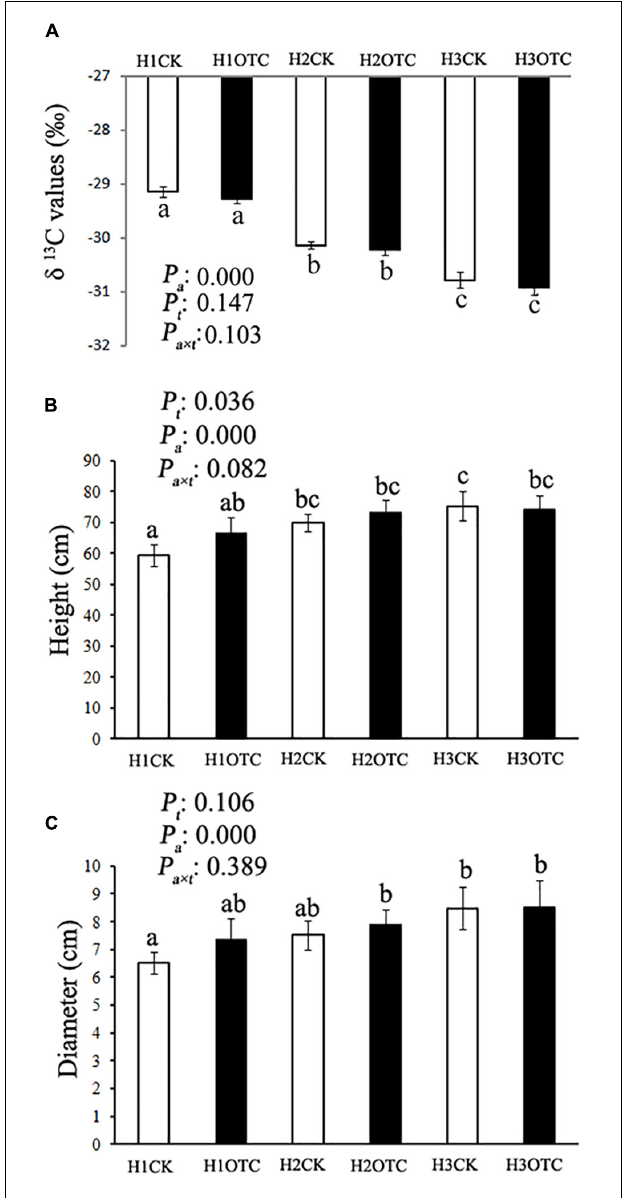
FIGURE 1 | The needle δ 13 C values (A) and the growth of height (B) and diameter (C) of A. faxoniana at 3,500, 3,000, and 2,600 m after 10-year warming. Values denoted the different letters indicates a significance at p < 0.05 according to Tukey test. P a , altitude effect; P t , open-top chamber (OTC) effect; P a × t , altitude and OTC interaction effect; H1CK, 3,500 m control; H1OTC, 3,500 m OTC warming; H2CK, 3,000 m control; H2OTC, 3,000 m OTC warming; H3CK, 2,600 m control; H3OTC, 2,600 m OTC